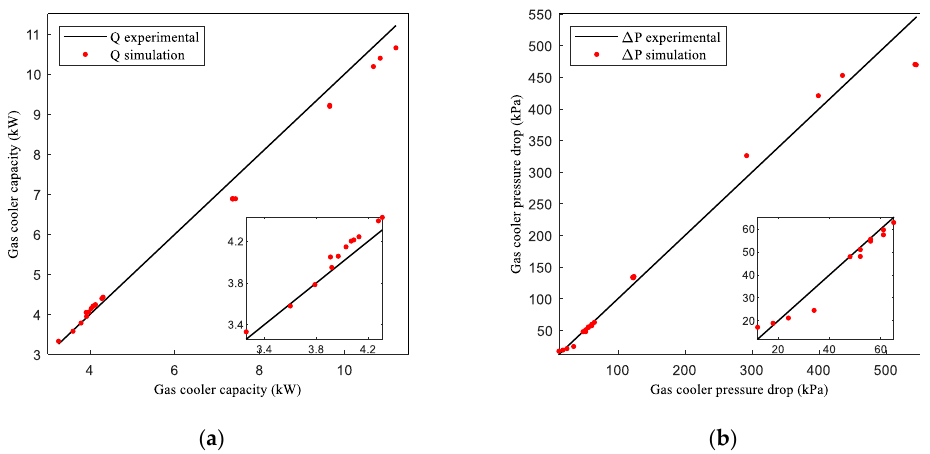
Figure 4. ( a ) Comparison of experimental vs. simulated gas cooler capacity; ( b ) comparison of experimental vs. simulated gas cooler pressure drop.